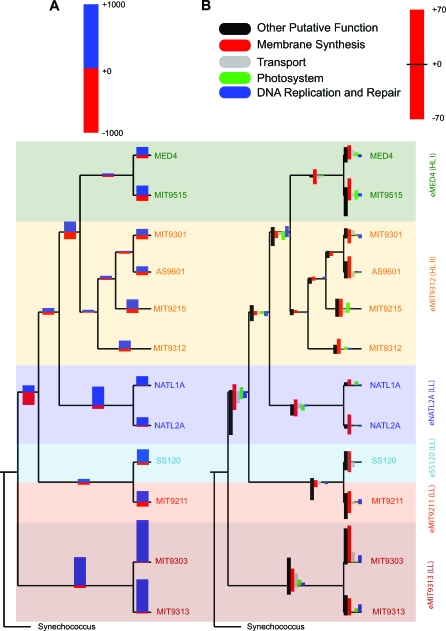
The Loss and Gain of Genes through the Evolution of Prochlorococcus
The ancestor node in which a gain or loss event took place was estimated by maximum parsimony. Four marine Synechococcus genomes (not shown) were included in the calculation, and the phylogenetic tree from Figure 2C was rooted between the Synechococcus and Prochlorococcus lineages.(A) The total number of genes gained and lost at each node.(B) The loss and gain of genes in that could be assigned functional roles through homology. Note that (B) focuses on the small minority of genes that do have an assigned function. Genes were assigned to one of five categories on the basis of keyword matches against the gene name or COG description. “Other Putative Function” refers to genes with assigned function but not belonging to the four major categories. Note the difference in scale for (A and B).